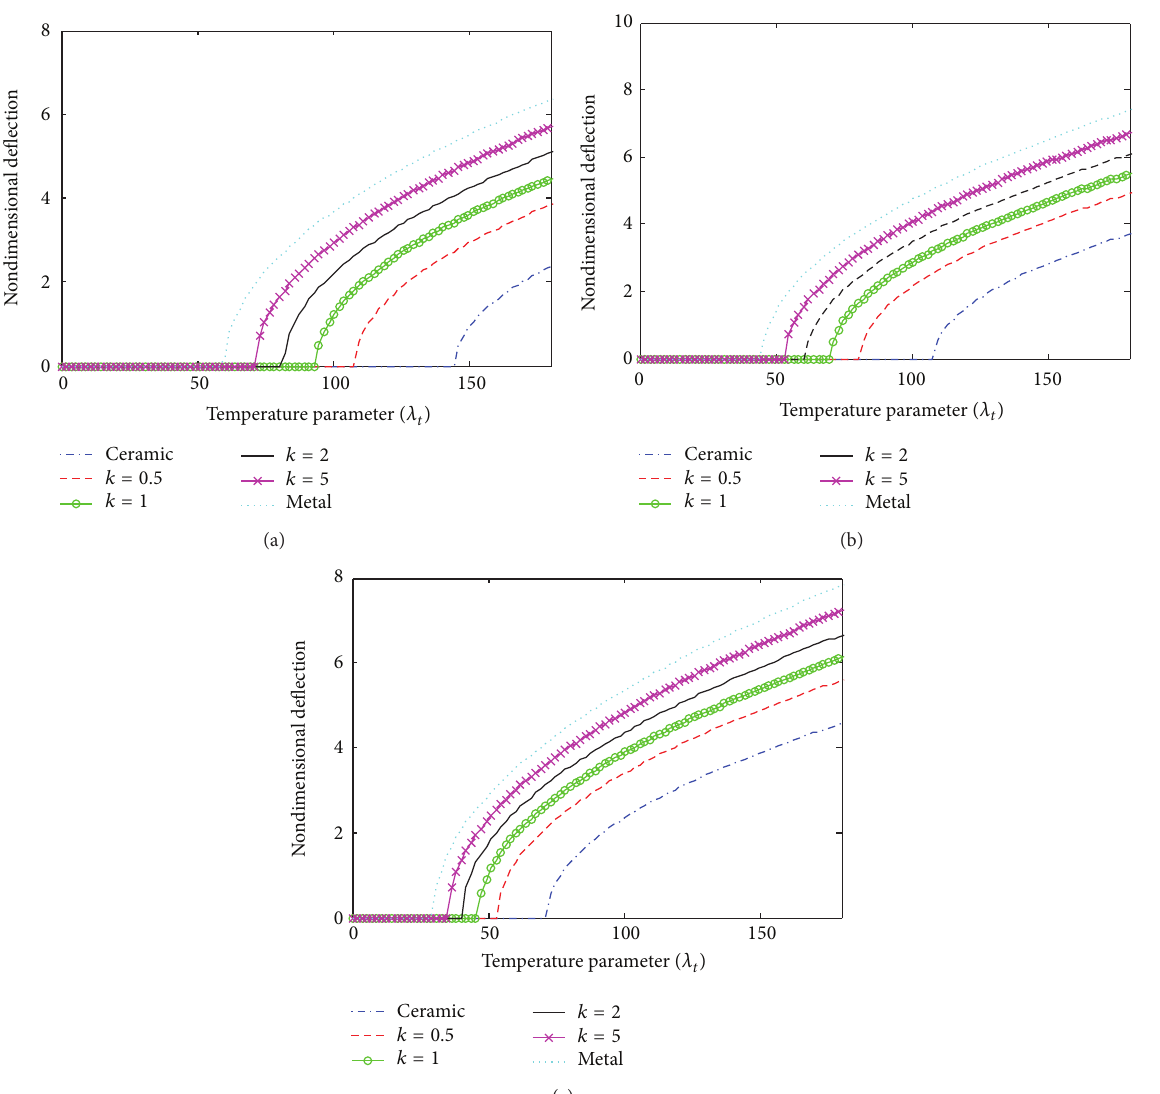
Figure 3: Variation of the nondimensional deflection ( ̂𝑥 = 0.25 ) of (a) clamped-clamped, (b) clamped-simply supported, and (c) simply supported-simply supported FG beam with the temperature parameter for different values of 𝑘 ( 𝑙/ℎ = 1 , 𝐿/ℎ = 40 , second buckling mode).